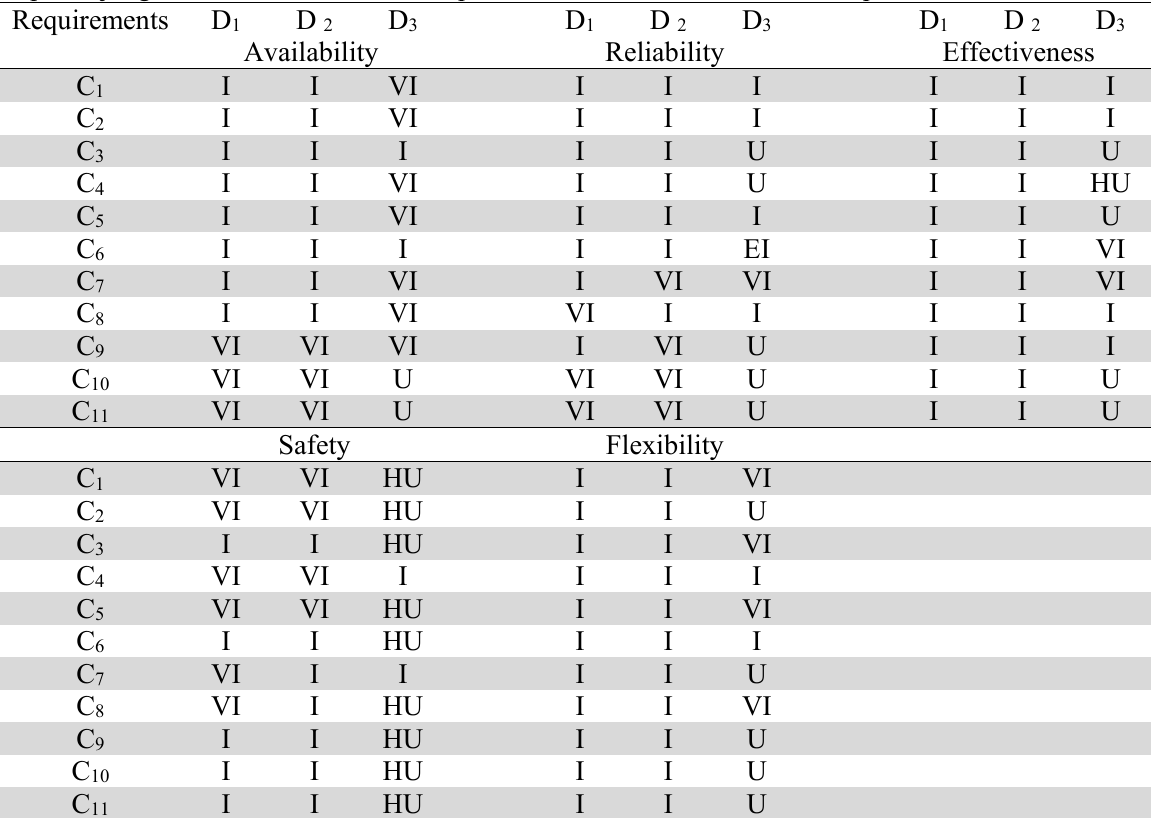
Expert’s judgment for the customers’ requirements and techno-economic requirements